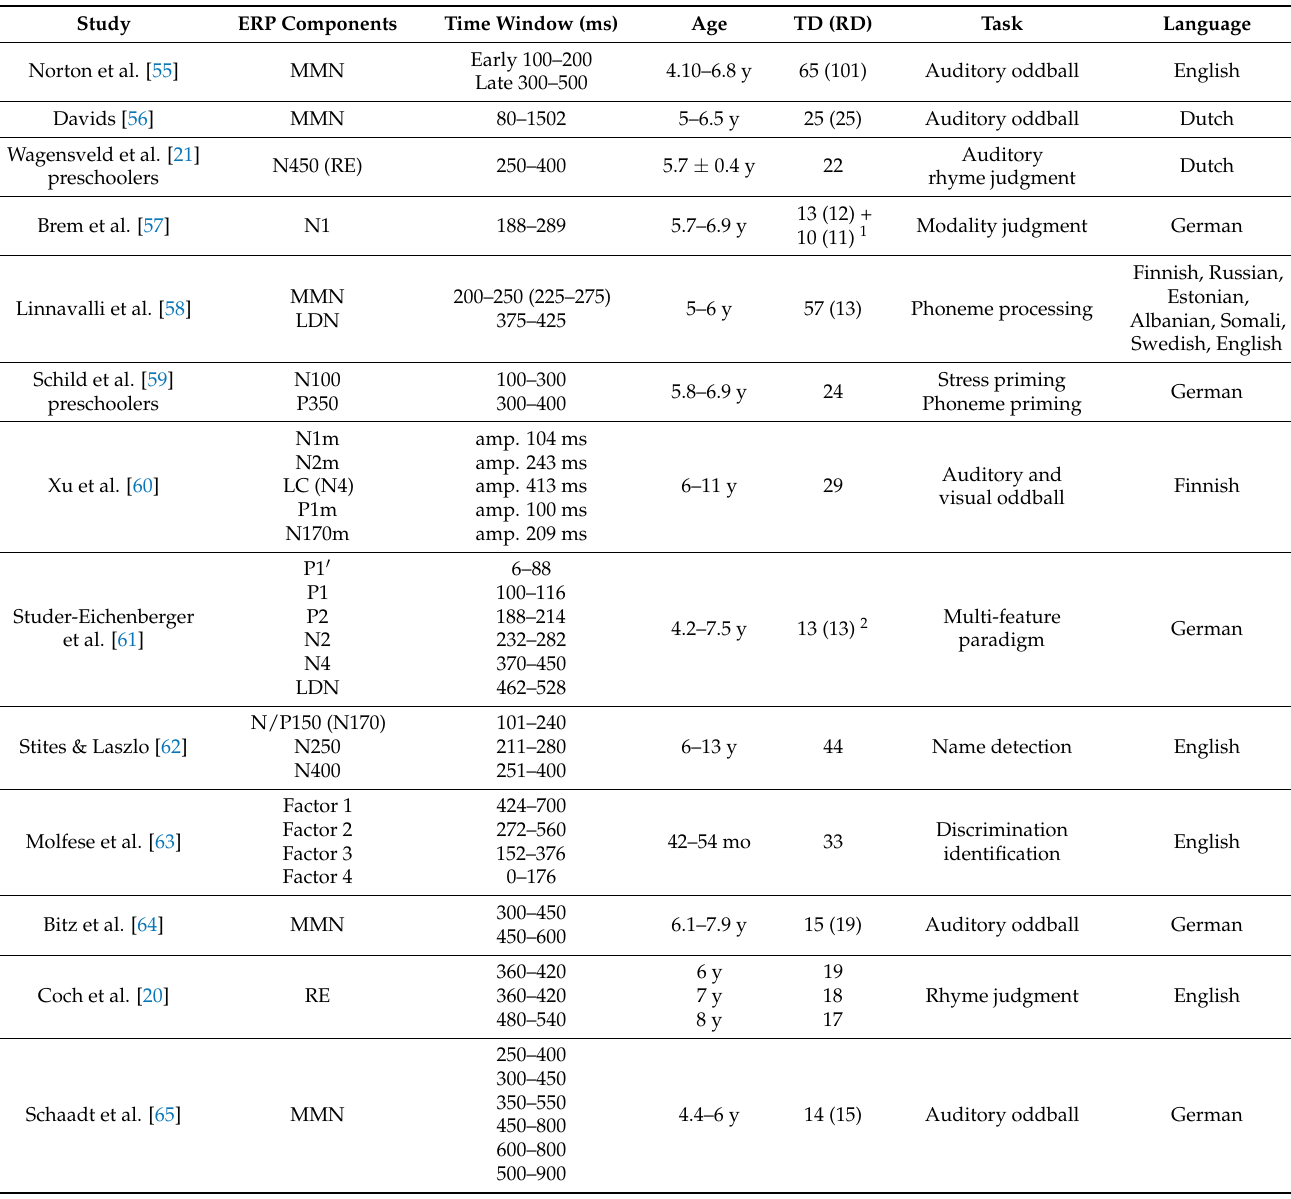
Table 2. Overview of the publications selected for review; studies with preschool